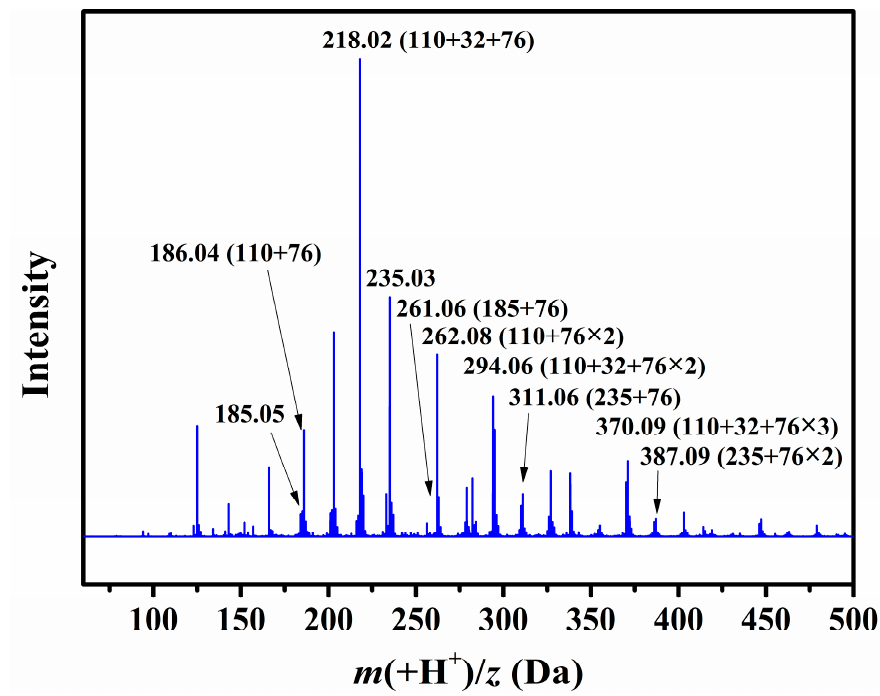
Figure 10. Q-TOF spectrum of sodium thiophenolate thermally treated at low temperatures in APCI positive mode.